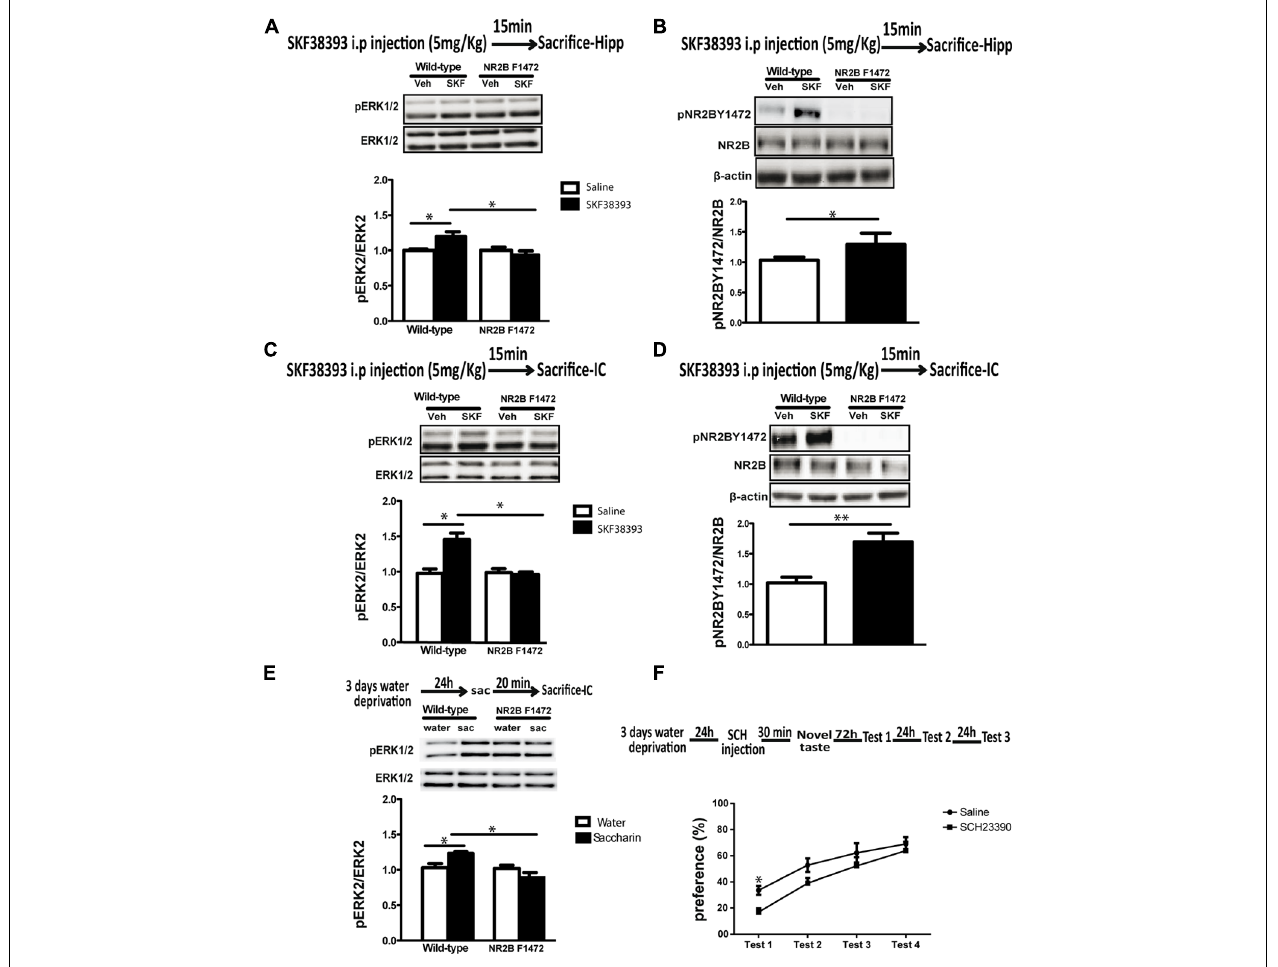
FIGURE 4 | Dopamine D1 receptor induces ERK1/2 and NR2BY1472 phosphorylation in vivo in both hippocampus and insular cortex. (A) Injection of SKF38393 (5 mg/kg, i.p.) increases pERK1/2 levels in wild-type mice hippocampus, but not in NR2B F1472 mice (* p < 0.05 vs. control and * p < 0.05 vs. wild-type SKF38393, n = 5). (B) Injection of SKF38393 increases NR2BY1472 phosphorylation levels in the wild-type mice hippocampus (* p < 0.05 vs. control), but not in NR2B F1472 mice ( n = 6). (C) SKF38393 (5 mg/kg, i.p.) increases pERK1/2 and (D) pNR2BY1472 levels